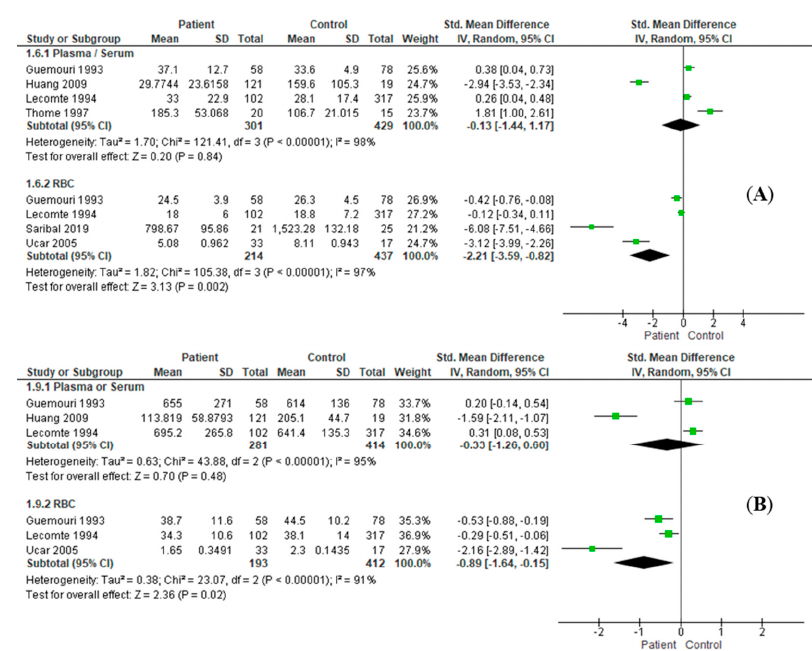
Figure 2. Comparing activities of antioxidative enzymes between alcohol-dependent patients and healthy controls in plasma/serum or RBC. Significantly different activities were found in SOD ( A ) in RBC (RE: SMD = − 2.21, I 2 = 97%, 95%CI = [ − 3.59, − 0.82], Z = 3.13, p = 0.002) but not in plasma/serum, GPx ( B ) in RBC (RE: SMD = − 0.89, I 2 = 91%, 95%CI = [ − 1.64, − 0.15], Z = 2.36, p = 0.02) but not in plasma/serum. CI, confidential interval; GPx, glutathione peroxidase; RBC, red blood cell; RE, random effect mode; SD, standard deviation; SMD, standard mean difference; SOD, superoxide dismutase.